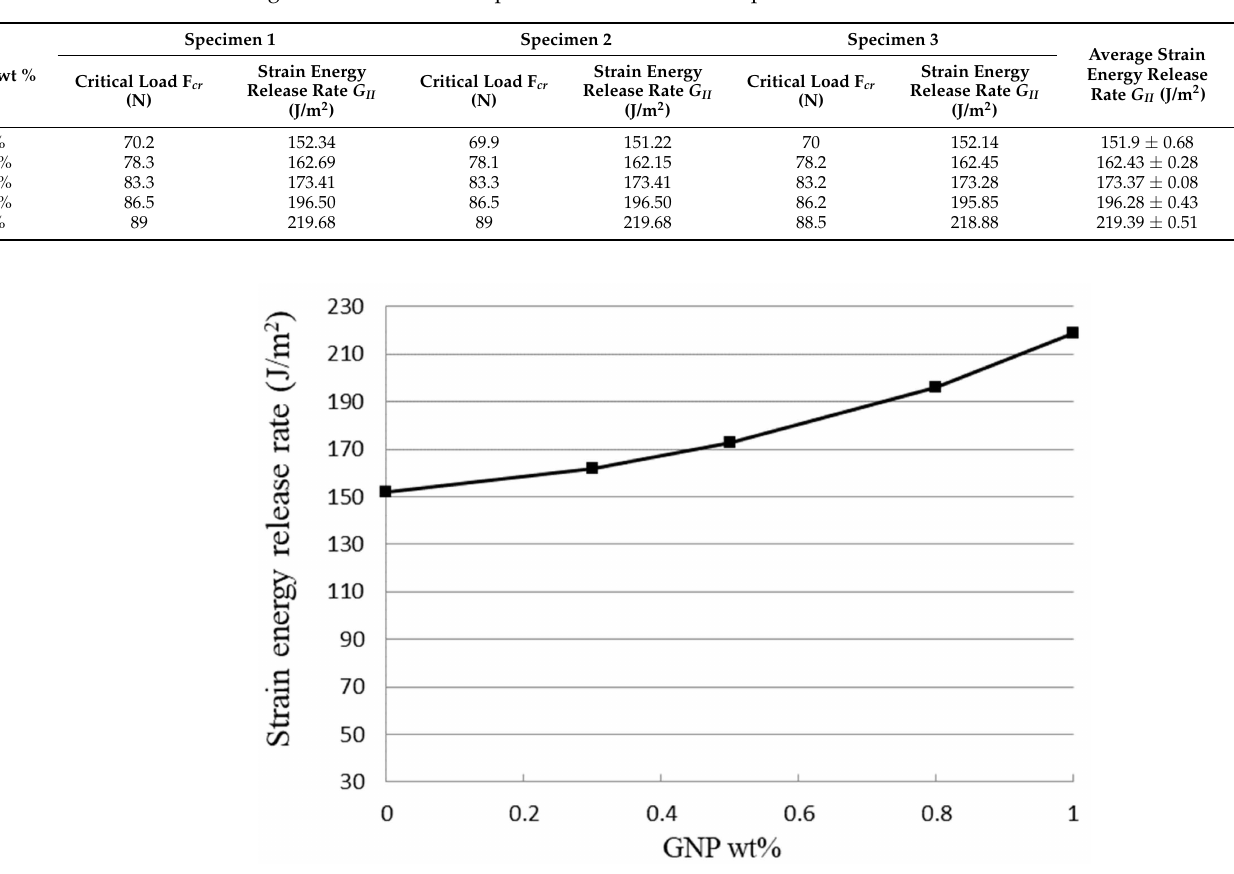
Table 2. Mode II fracture toughness of the nanocomposite film/substrate composite structure with various GNP contents.